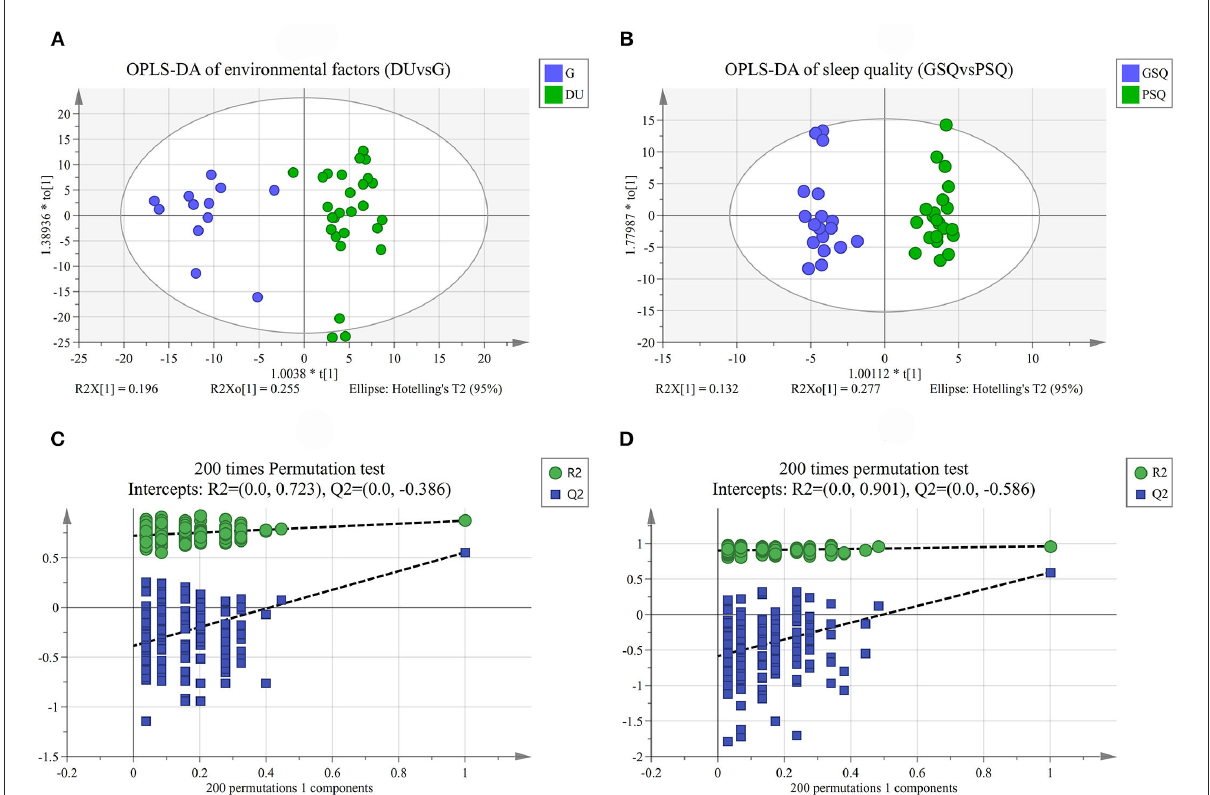
FIGURE2 (A) is the OPLS-DA of environmental factors group (DUvsG), and DUvsG refers to the group “Deep-underground vs. ground”; (B) is the OPLS-DA of sleep quality group (GSQvsPSQ), and GSQvsPSQ refers to the group “Good sleep quality vs. poor sleep quality;” (C) is the results of 200 times permutation test in DUvsG group; (D) is the results of 200 times permutation test in GSQvsPSQ group. The quality of the model was evaluated by its explicative ( R 2 ) and predictive ( Q 2 ) abilities. OPLS-DA refers to the orthogonal partial least-squares-discriminant